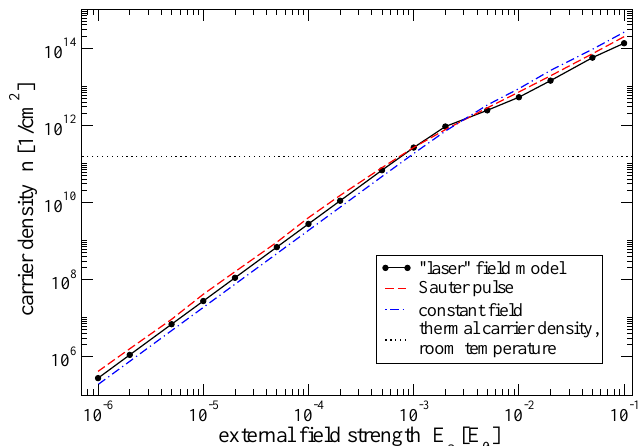
Figure 10. The dependence of the carrier density for the electric field models (57), (58) and